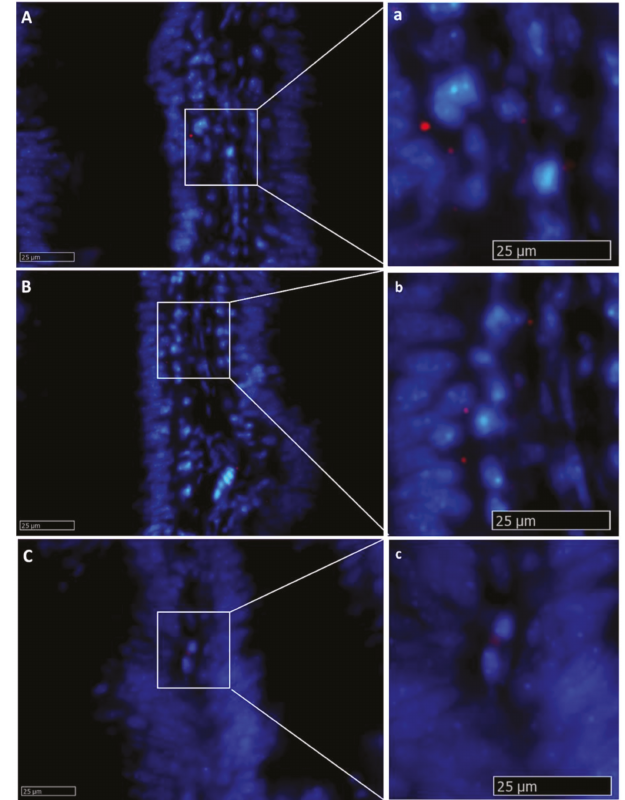
Figure 17. In situ hybridization of wnt3a mRNA in the rainbow trout mid-intestine (red dots). The signal was lower in the first segment of the mid-intestine ( A , a ): higher magnification), in the pyloric caeca ( B , b ): higher magnification), and in the apical part of the complex folds of the second segment of the mid-intestine, compared to the basal part of the complex folds ( C , c ): higher magnification) and to the rest of the second segment of the mid-intestine.